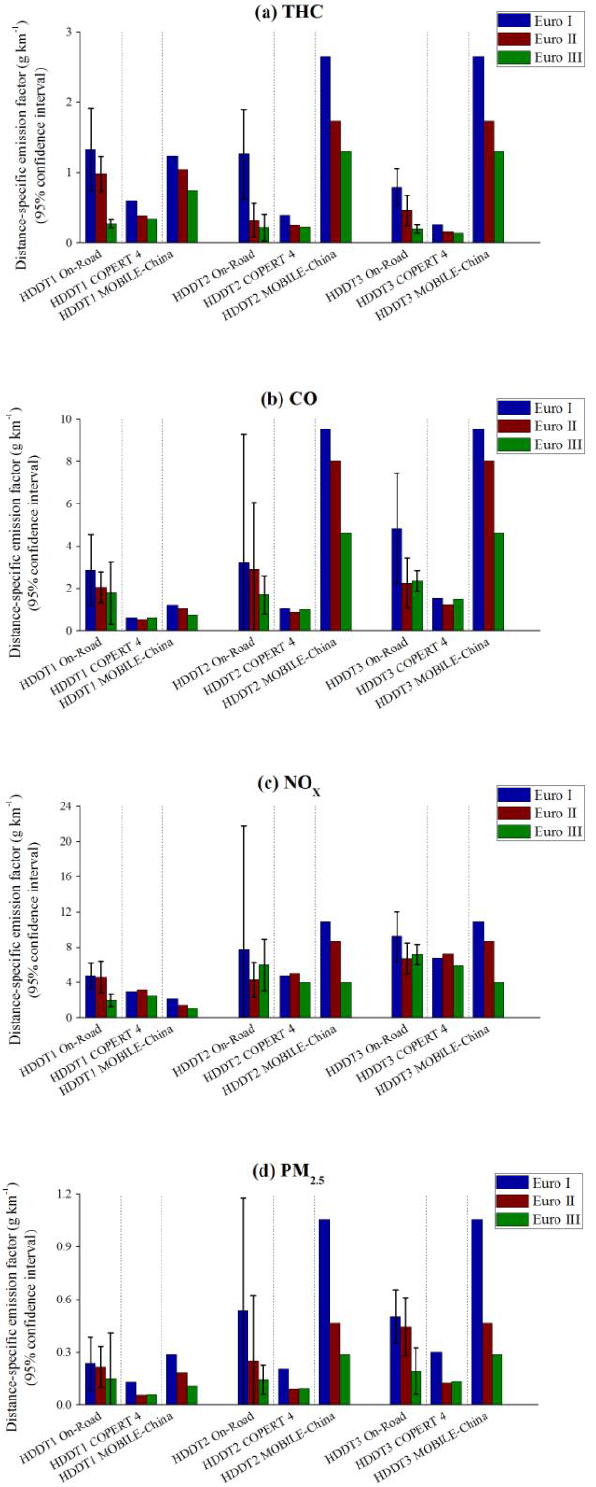
Fig. 6. Emission factors of (a) THC, (b) CO, (c) NO x and (d) PM 2 . 5 for Euro I, Euro II and Euro III HDDTs under a typical driving cycle with an average speed of 40kmh − 1 .